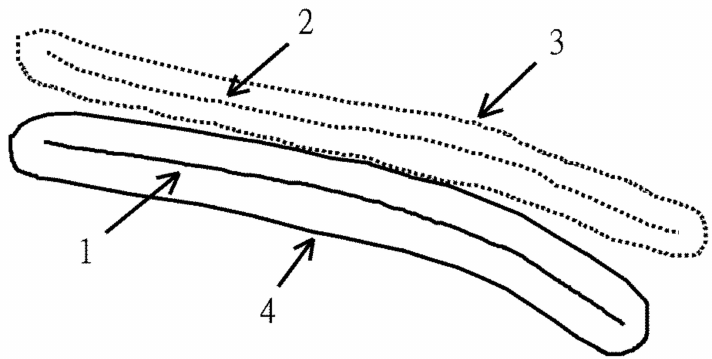
Figure 5. Region growing territory method. Solid line 1 represents one curve. Dot line 2 represents another curve. 1 and 2 are seen as seed and grow to two territories (3 and 4). The two territories meet and form central curve. If they do not meet, they will keep on